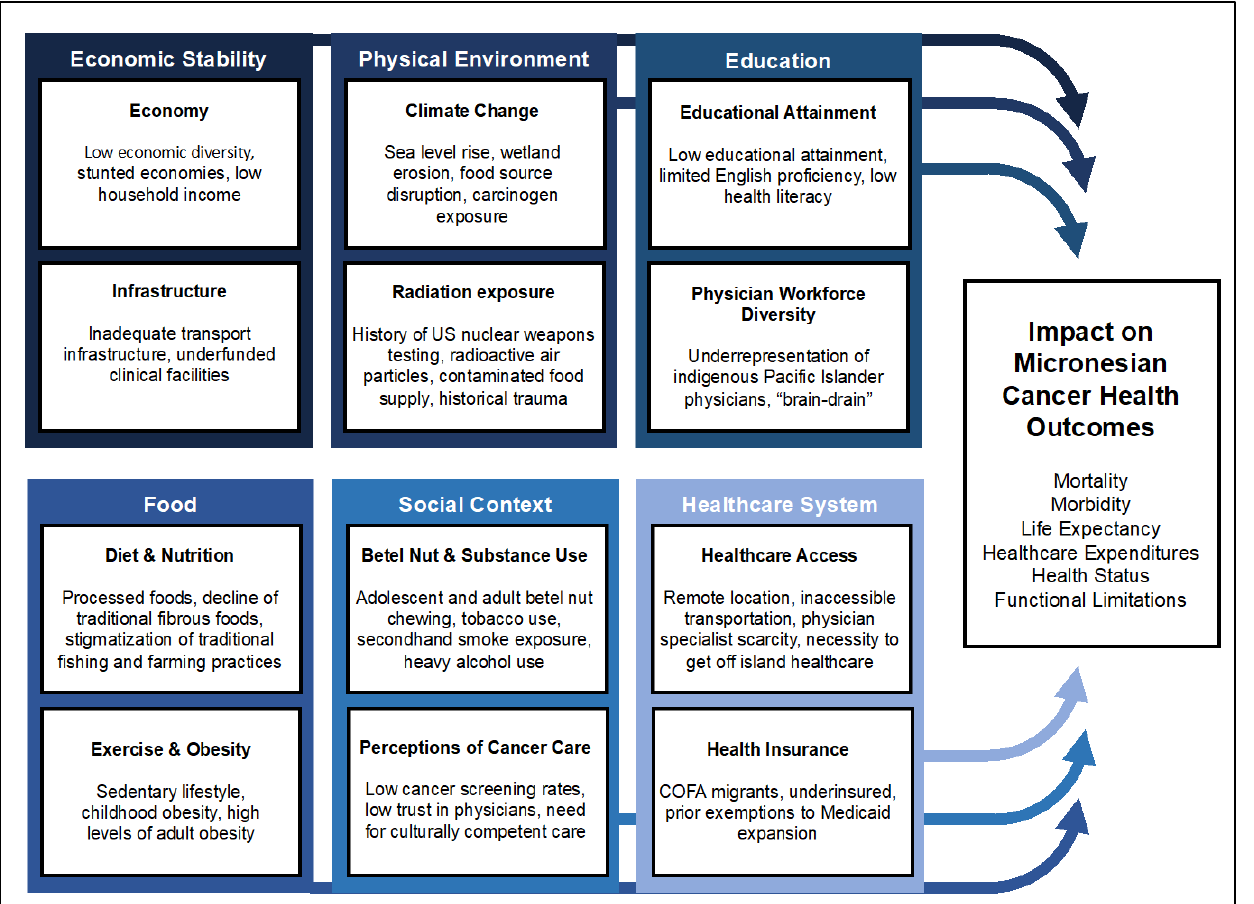
Figure 3. Conceptual framework of the social determinants of health as it pertains to Micronesian cancer disparities. Some of the known social determinants of health include economic stability, physical environment, education, food, social context, and the healthcare system.